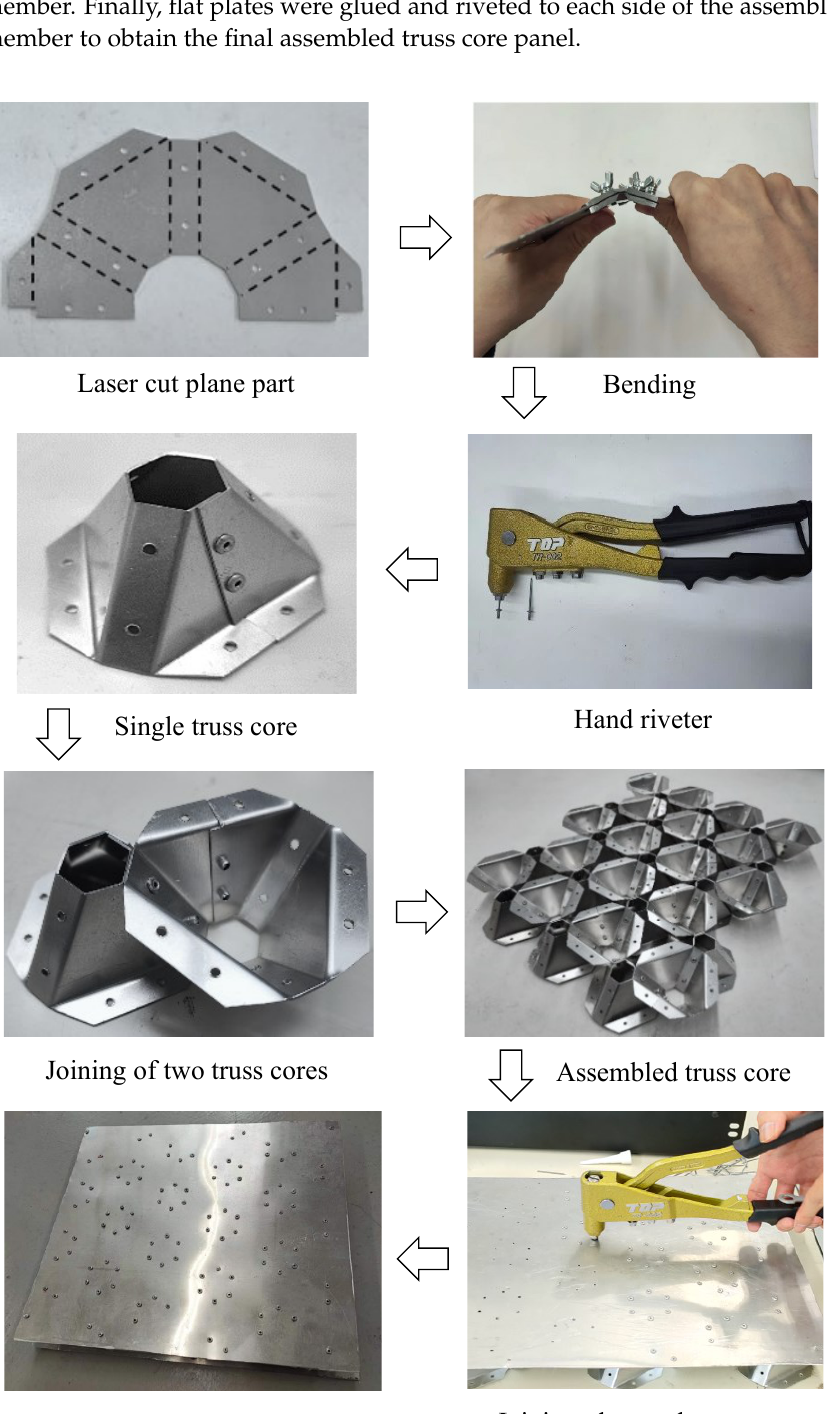
Figure 10. Processing experiment of an assembled truss core panel.